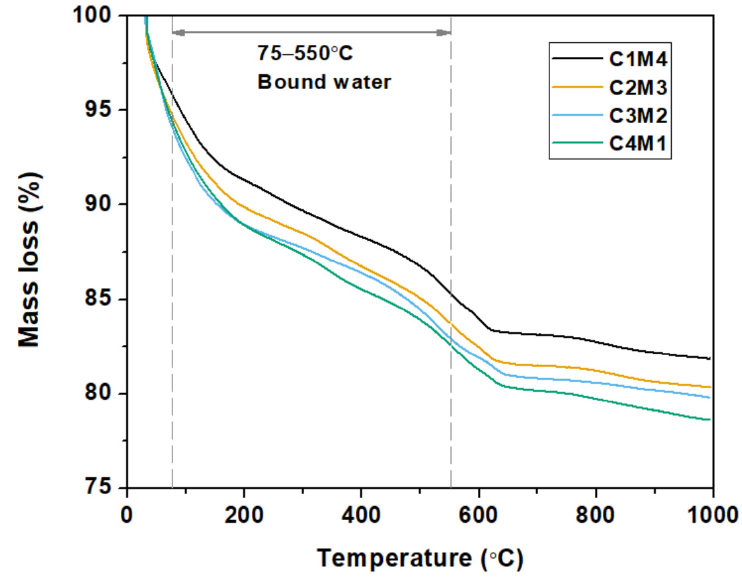
Figure 7. XRD patterns of the Na 2 CO 3 -activated slag binders modified with Ca(OH) 2 and Mg(OH) 2 .